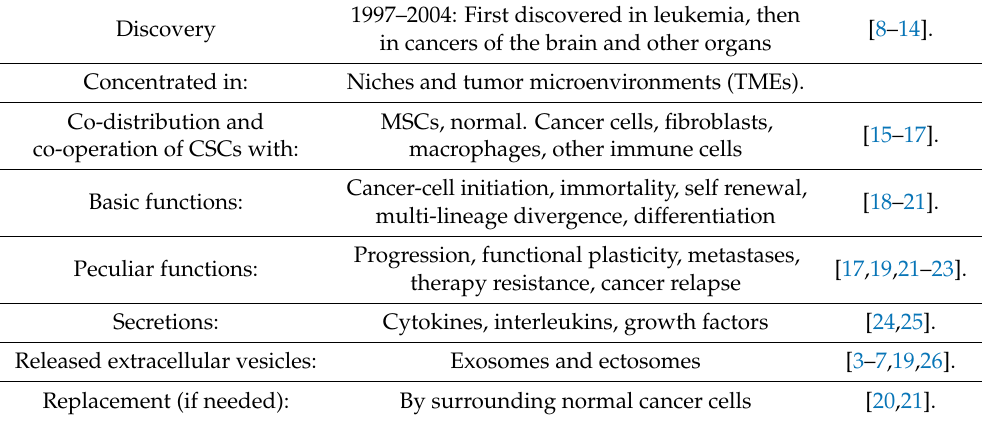
Table 1. History and properties of